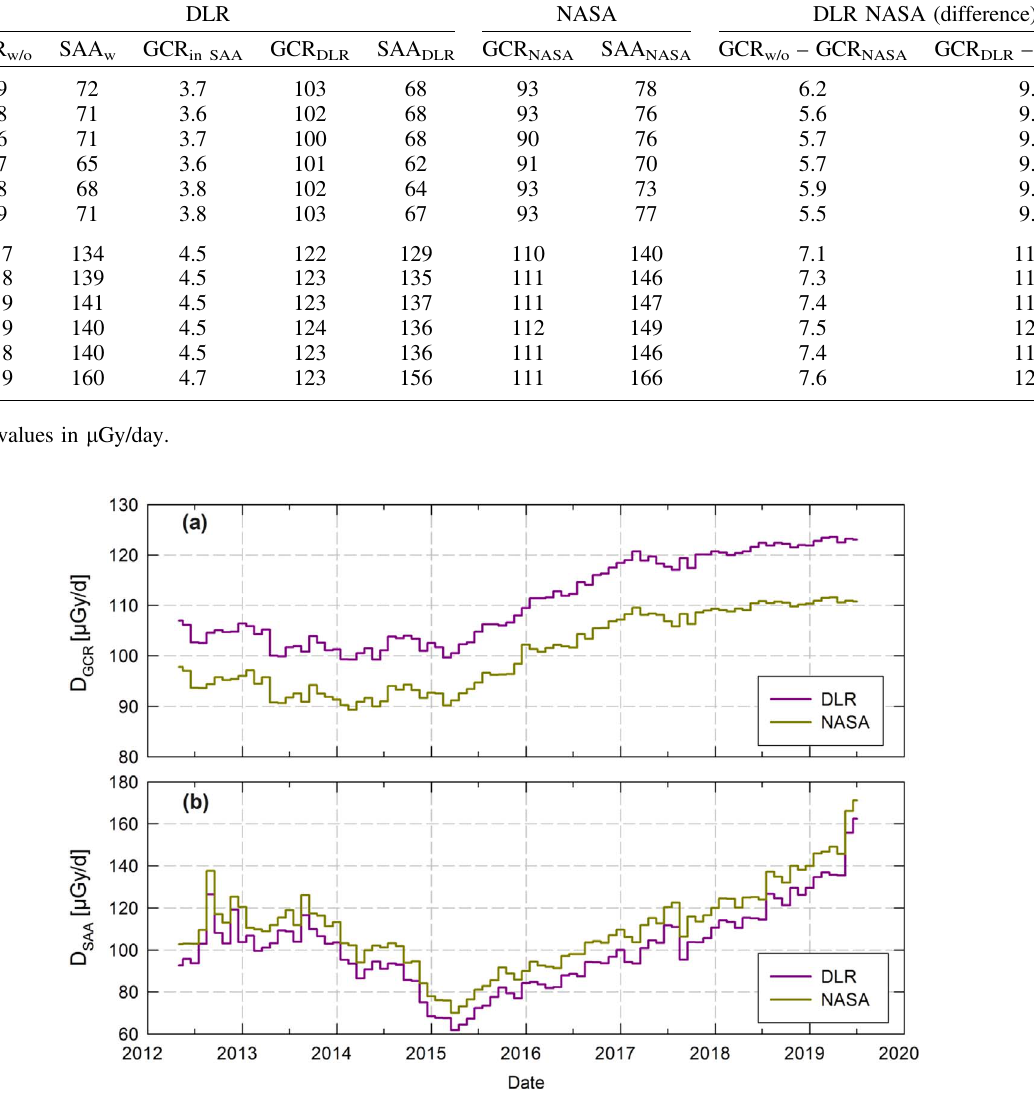
Table 2. Comparison of GCR and SAA doses derived by DLR and NASA-SRAG procedure for two six months ’ time periods in 2015 and 2019. MM.YY